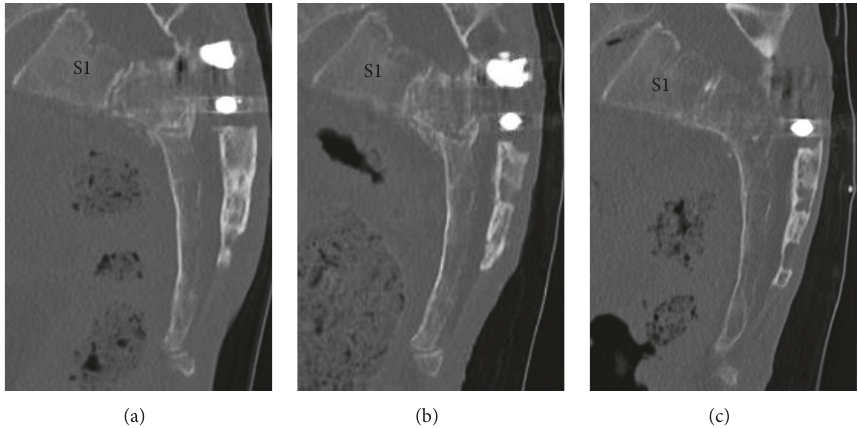
Figure 4: Follow-up sagittal reconstructed computed tomography (CT) images of the sacrum . (a) One-month sagittal reconstructed CT image. (b) Three-month sagittal reconstructed CT image. (c) One-year sagittal reconstructed CT image. The second-third sacral vertebral body exhibited a high-density area (a). The high-density area in the second-third sacral vertebral body increased (b). The second-third sacral vertebral body had united without any displacement